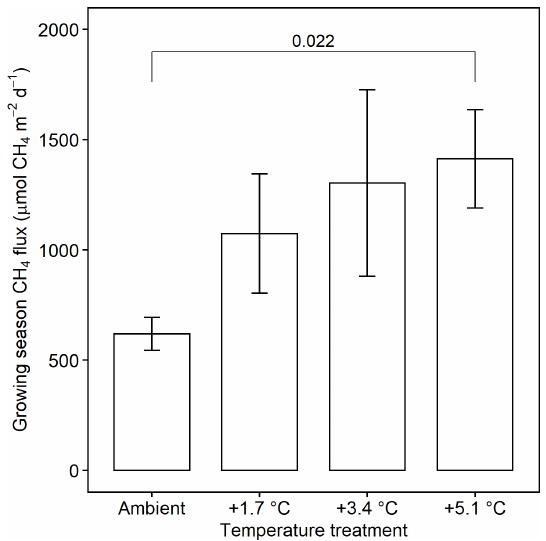
Figure 2. Comparison of CH 4 emissions from each warming treat- ment during the growing season (May–September). Means include both the C 3 and C 4 community and all years of measurement. Er- ror bars indicate SE. Horizonal bars indicate means that are signifi- cantly different and the corresponding p adj